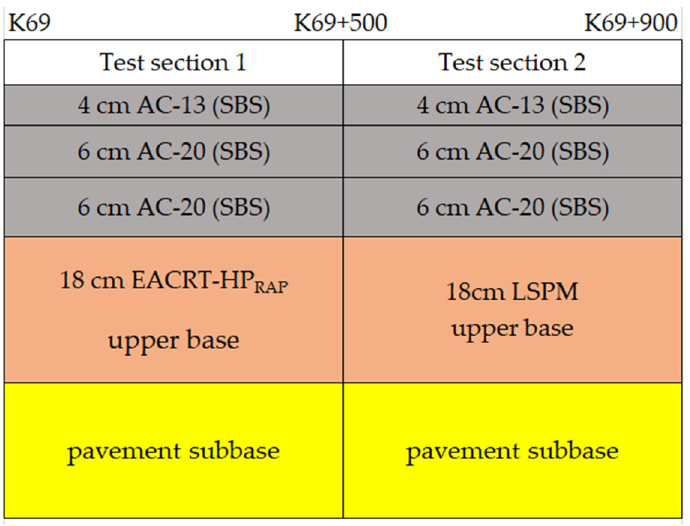
Figure 4. Schematic diagram of the pavement structures of the two test